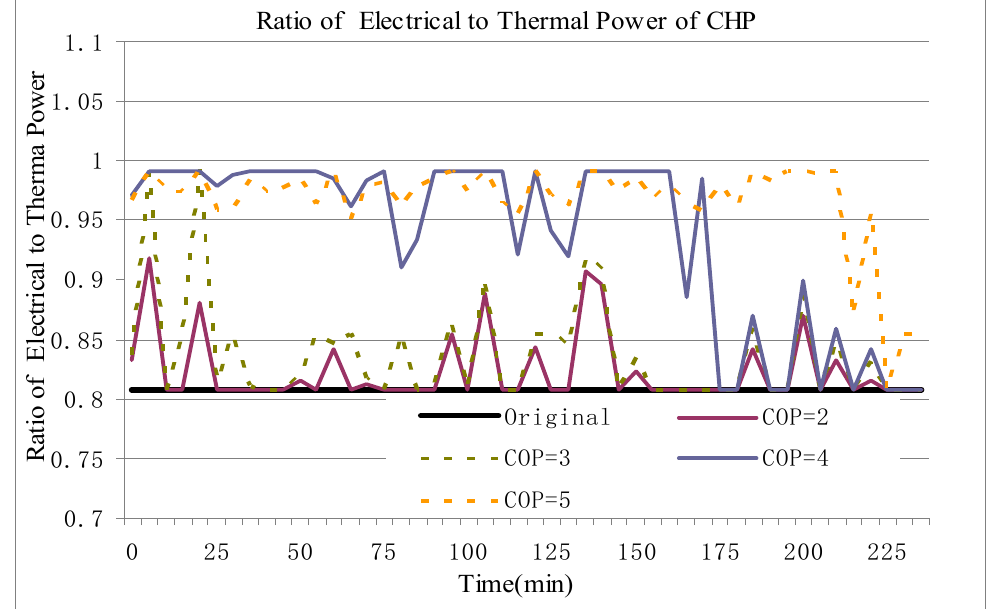
Figure 9. Adjustment of Ratio of Electrical Power to Thermal Power of CHP. Ratio of Electrical to Thermal Power of